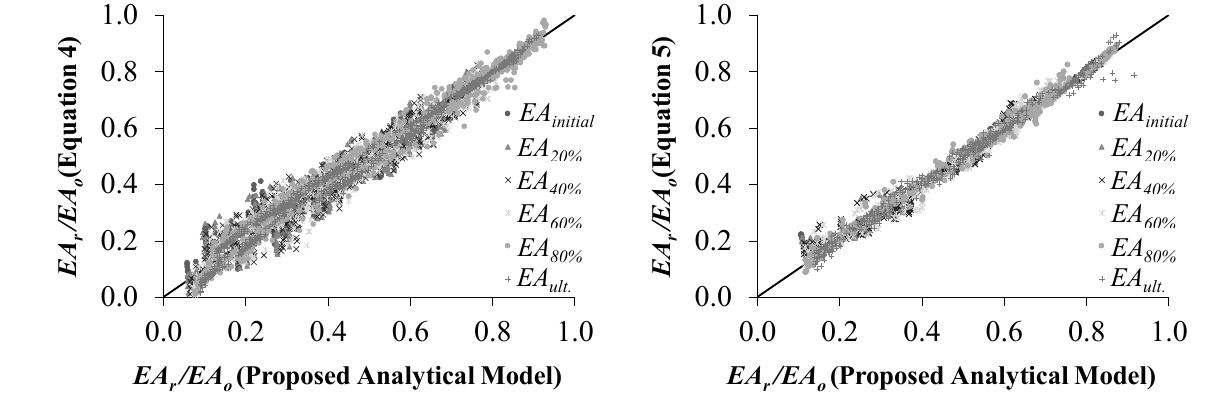
Figure 15. Validation of the proposed Equations (4) and (5) for residual capacity.